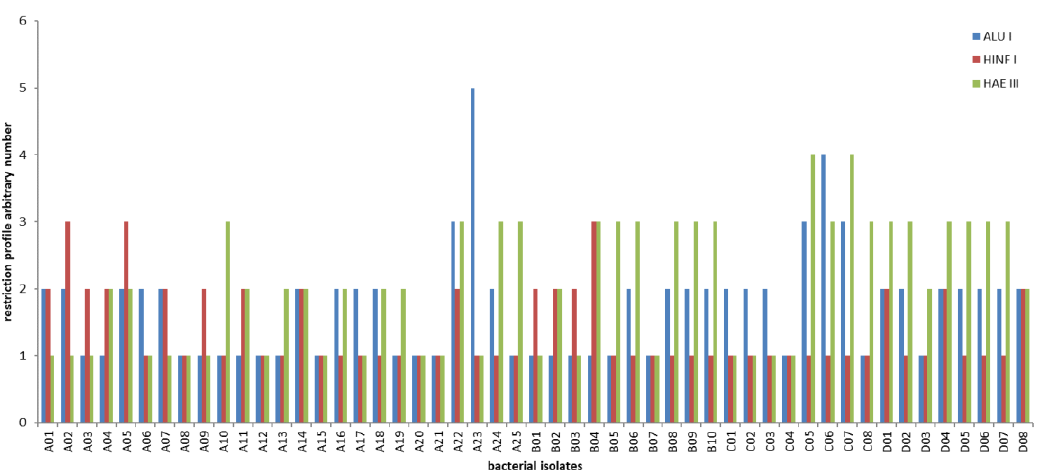
Figure 3. Histogram representation of different restriction profiles obtained using three different restriction enzymes (AluI, HaeIII, and HinfI). An arbitrary number has been attributed to each diverse digestion profile.